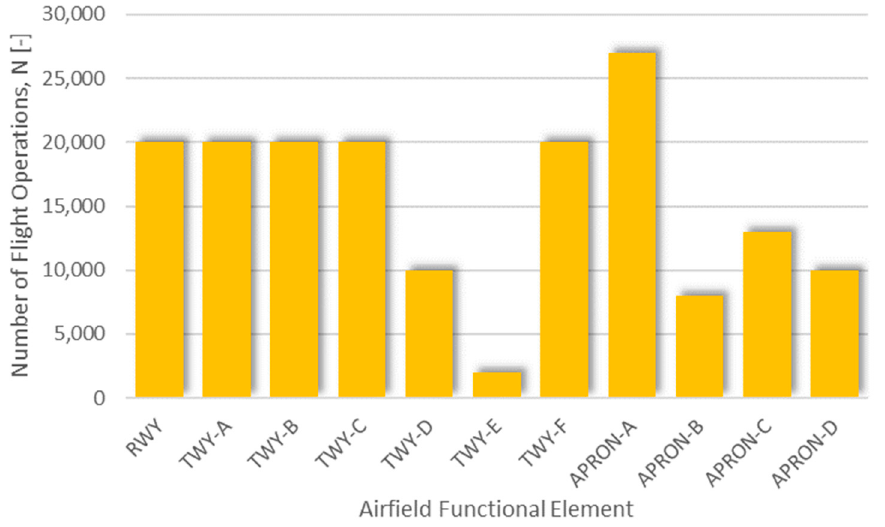
Aerospace 2020 , 7 , x Figure 10. Results of the pavement load bearing capacity test. Figure 10. Results of the pavement load bearing capacity test.